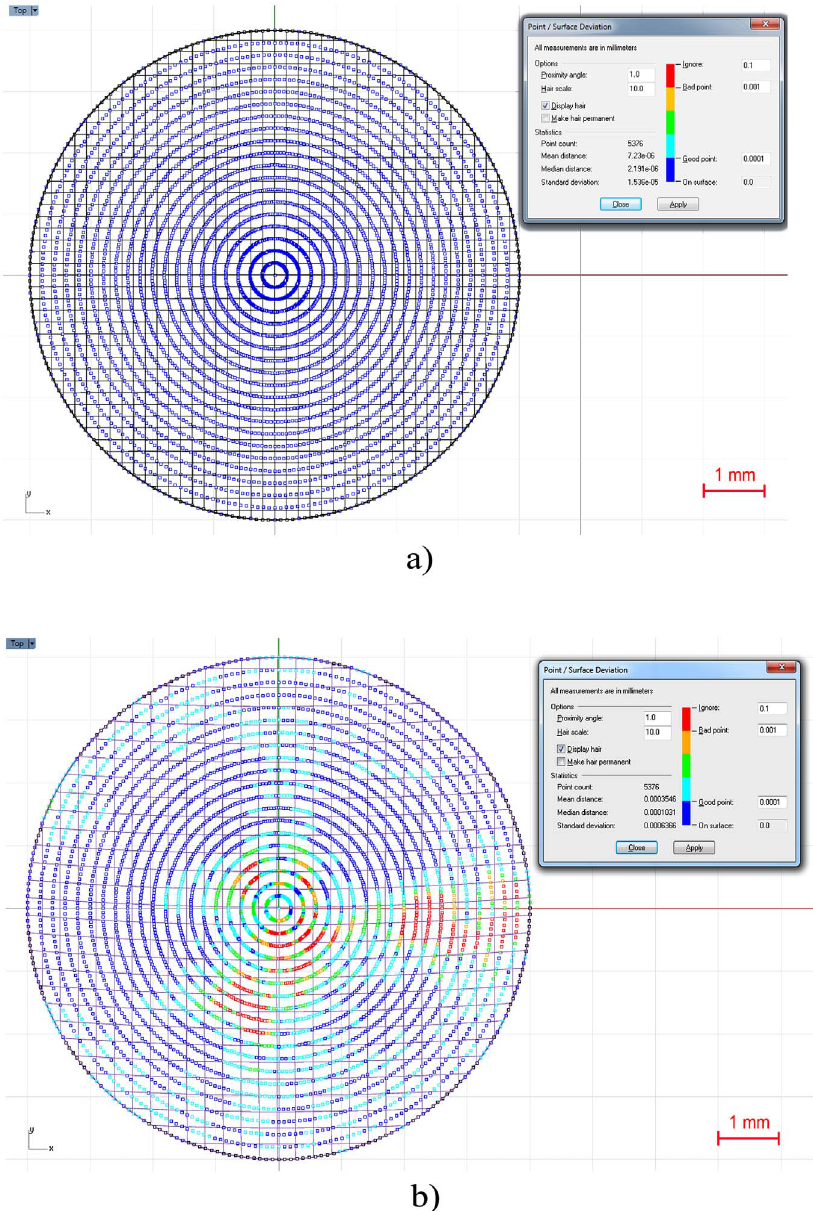
Figure 2. Analysis of the point-surface deviation for the anterior surface reconstruction of: a) a healthy cornea, b) a cornea with advanced